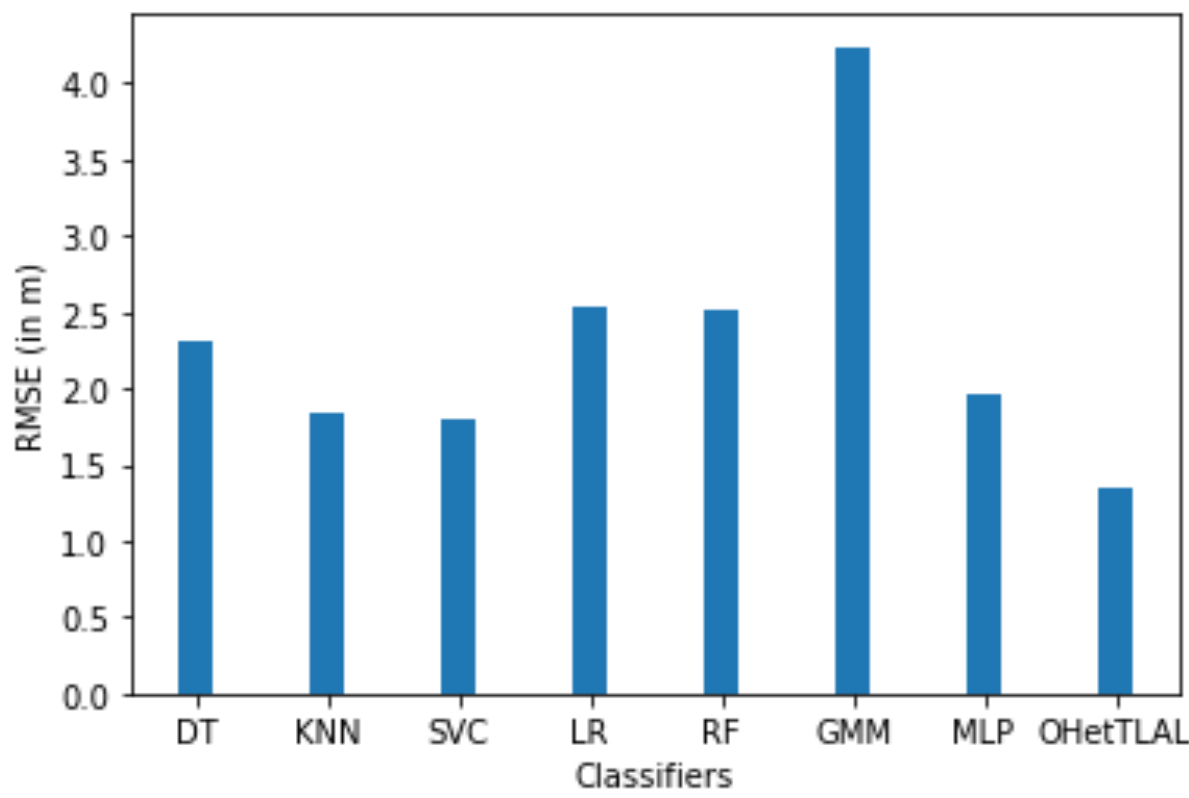
Figure 13. Comparisons of classifier’s RMSE for dataset A with 15 Wi-Fi APs.